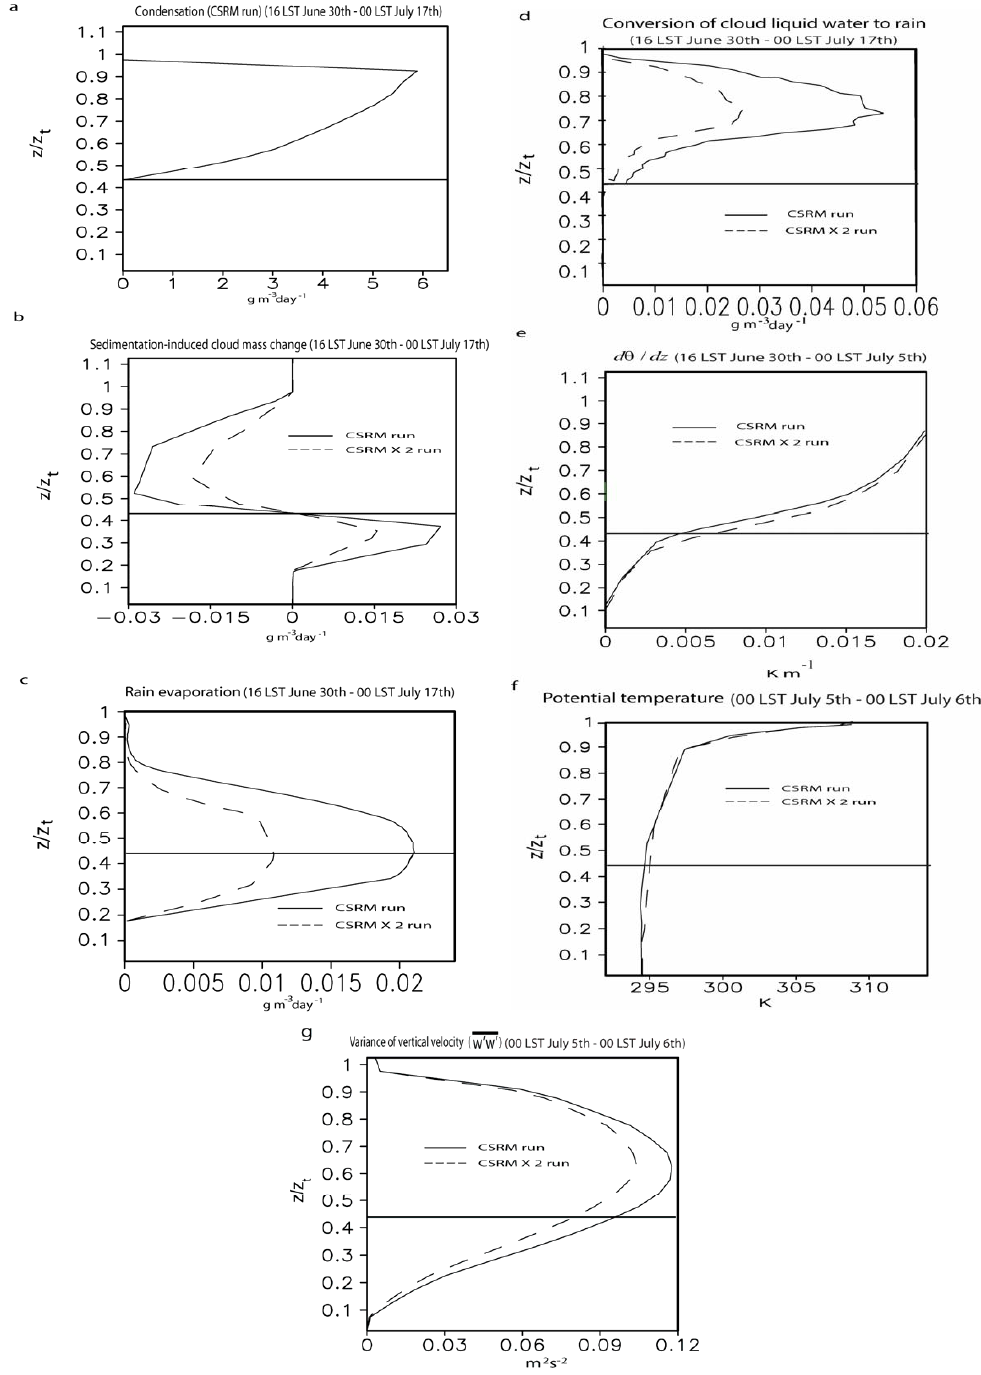
Fig. 17. Vertical distribution of time- and area-averaged (a) condensation for the CSRM run, (b) sedimentation-induced cloud mass change, (c) rain evaporation, and (d) conversion of cloud liquid water to rain in gm − 3 day − 1 for the CSRM run and the CSRM × 2 run over 16 LST 30 June–00 LST 17 July. (e) , (f) , and (g) are the vertical distribution of time- and area-averaged dθ respectively, for the CSRM run and the CSRM × 2 run. (e) is averaged over 16:00LST 30 June–00:00LST 5 July and (f) and (g) are averaged over 00:00LST 5 July–00:00LST 6 July. The solid horizontal line in each figure is the average cloud-base height normalized with respect to cloud-top height (z t